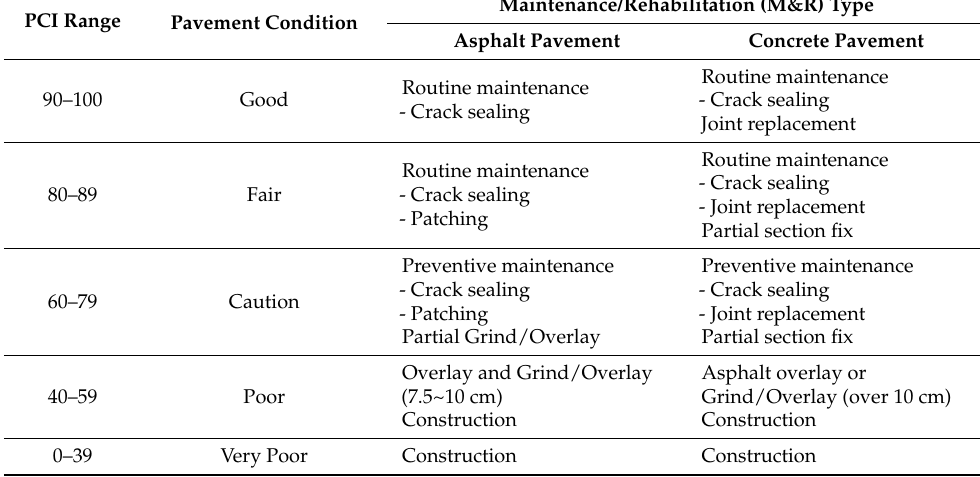
Table 1. PCI Score Rating and M&R